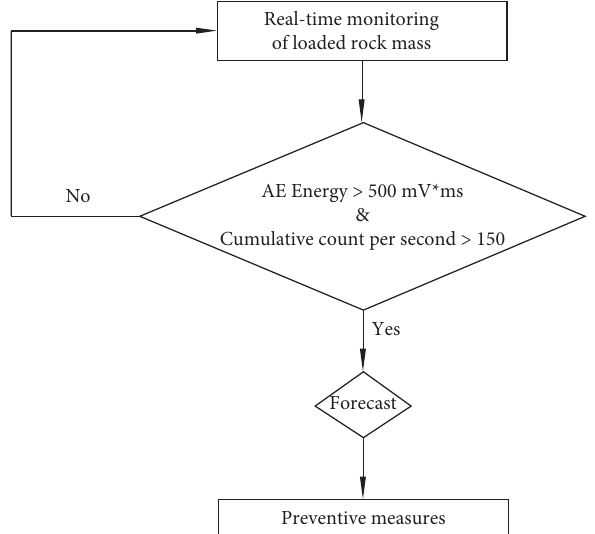
Figure 8: Early warning process of loaded rock based on data mining.